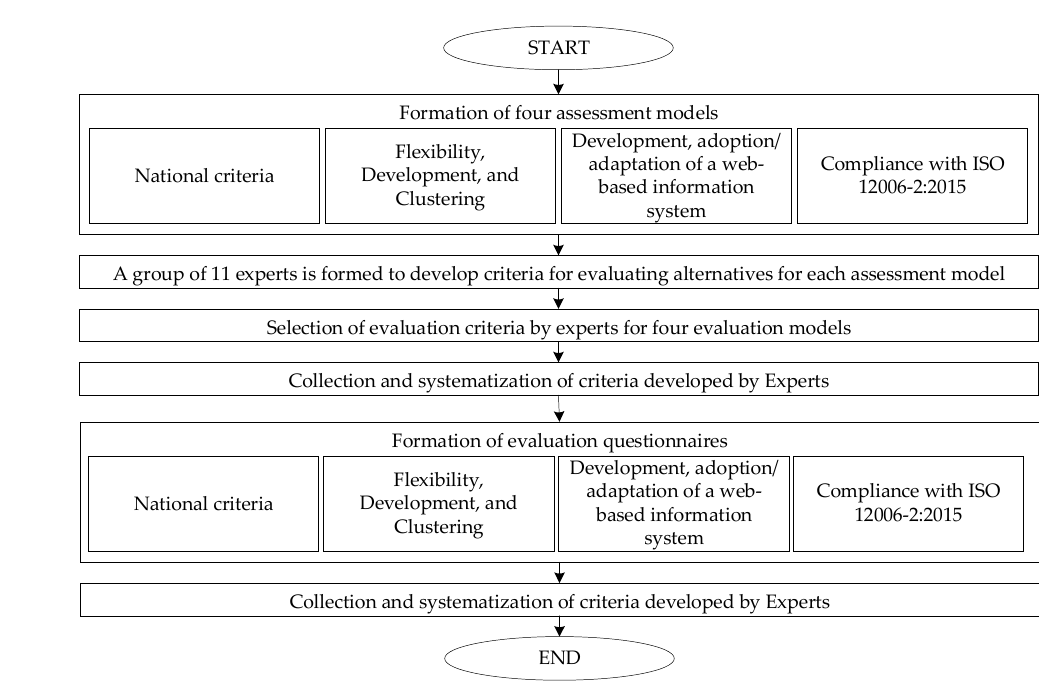
Figure 1. Schematic of development of four evaluation models (drawn by authors). Table 2. NCICS alternative assessment model in terms of national